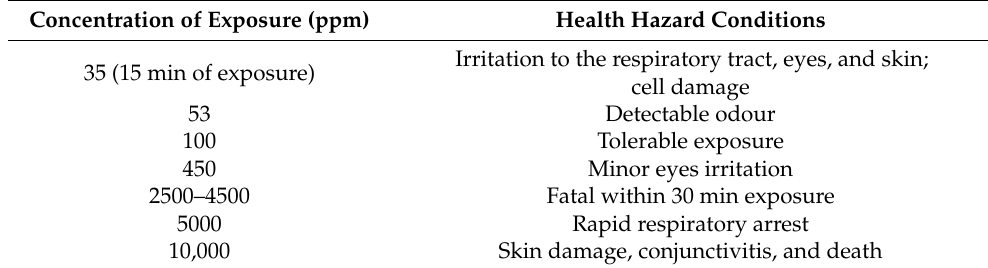
Table 1. Effects of ammonia exposure on human health [20]. Concentration of Exposure